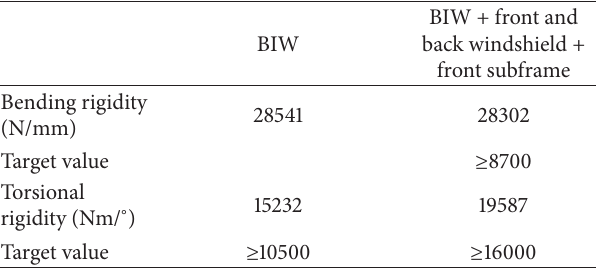
Figure 1: The rear floor structure of E-REV.